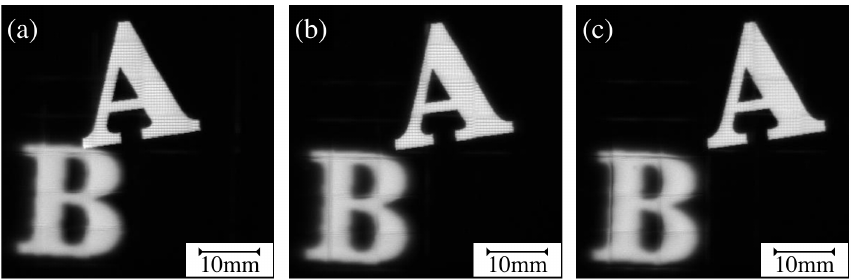
Figure 7. Capturing two letters in different depth planes to show the parallax effect. ( a ) Viewing angle of 3.1 ◦ , ( b ) camera placed on the optical axis, and ( c ) viewing angle of − 3.1 ◦